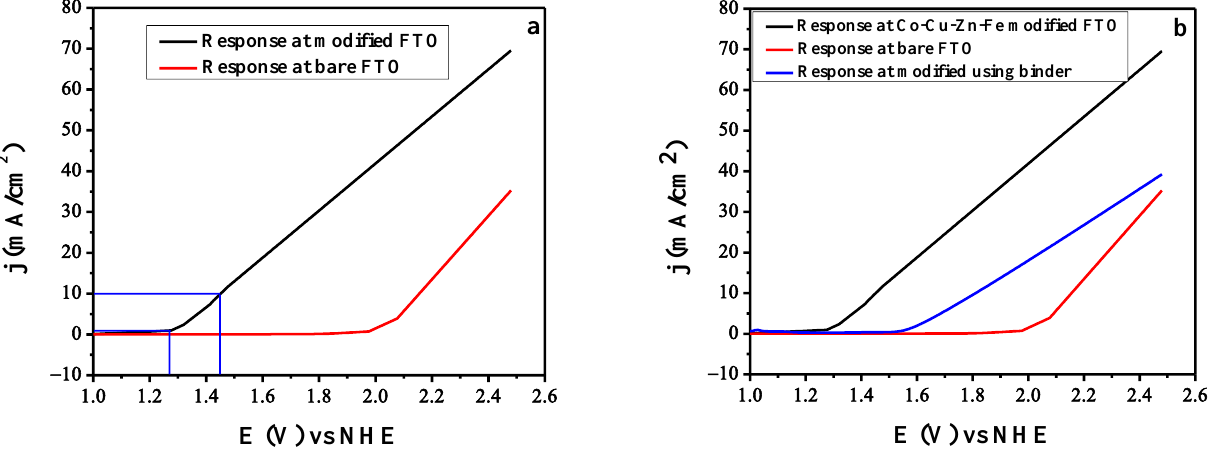
Figure 5. ( a ) LSV response of Co-Cu-Fe-Zn catalyst in 1 M KOH (pH = 13) at a scan rate of 10 mV/s. ( b ) LSVs showing the effect of binder on the catalytic performance of modified FTO in KOH (pH = 13) at a scan rate of 10 mV/s.